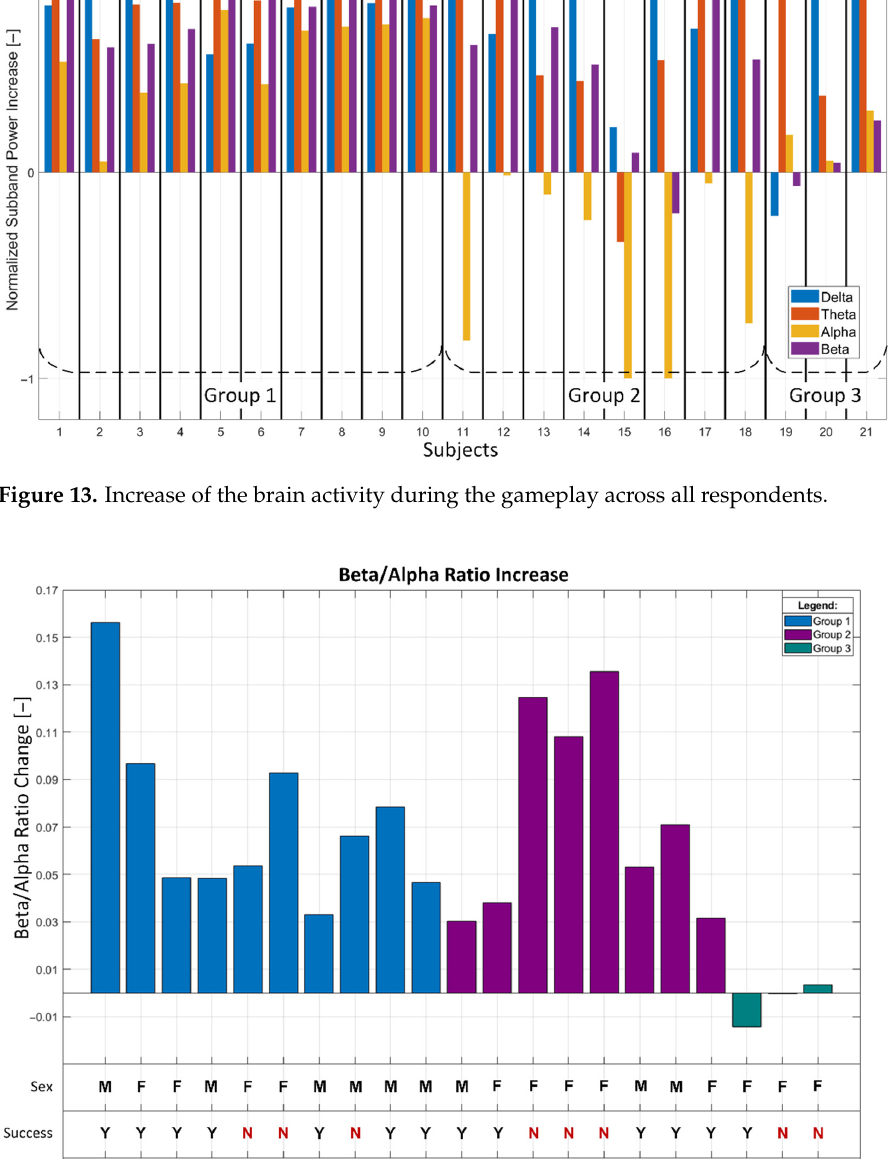
Figure 14. Increase of the Beta/Alpha ratio during the gameplay. The indicator of the subject’s sex, game success, and total game playtime is also